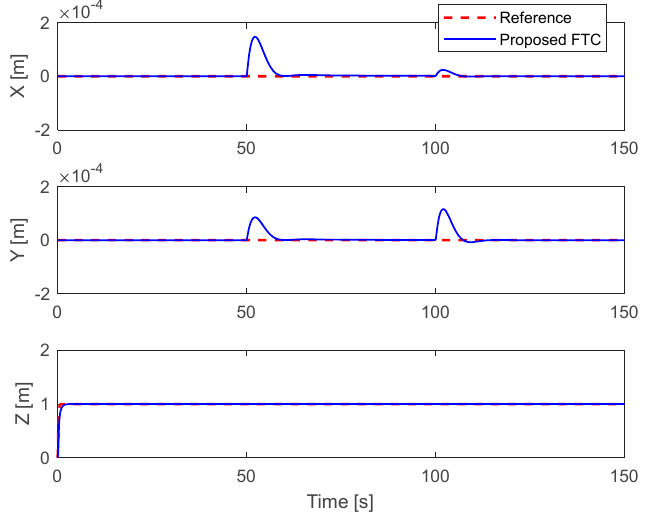
Figure 5. Altitude and position performance with complete fault in actuator 1 and partial fault in actuator 2.